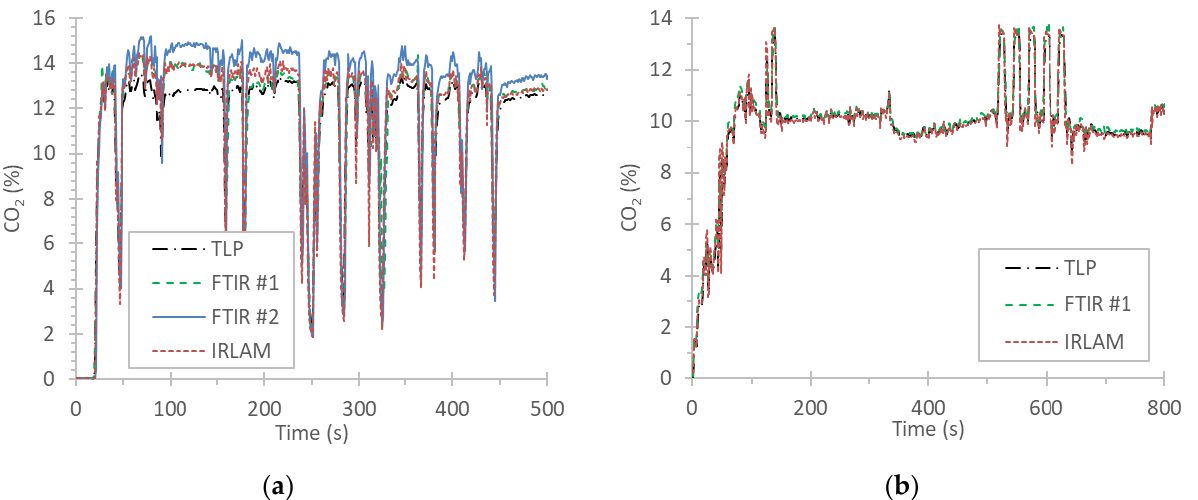
Figure 2. Real time CO 2 tailpipe concentrations during: ( a ) a cold start WLTC of the gasoline Euro 4 (G4) vehicle; ( b ) steady 130 km/h test with regeneration of the Diesel Euro 6 (D6) vehicle.